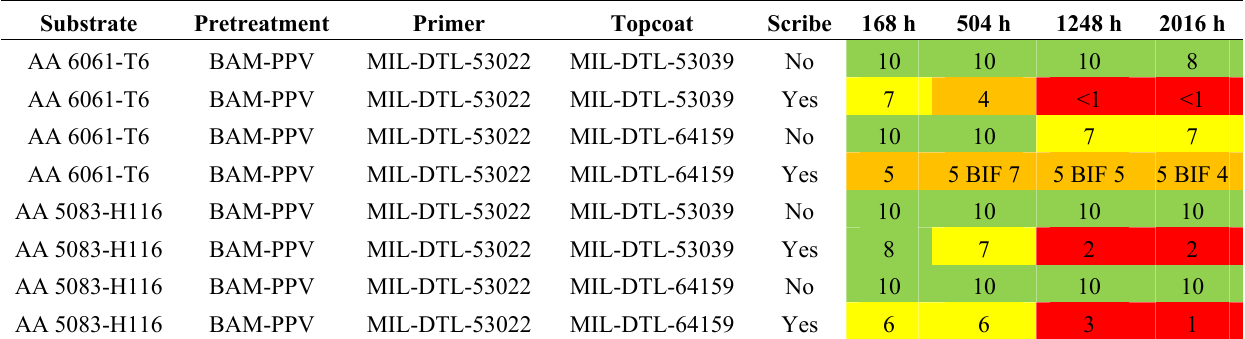
Table 5. ASTM D 1654 ratings for as-received AA 6061-T6 and AA 5083-H116 coupons in the NSS